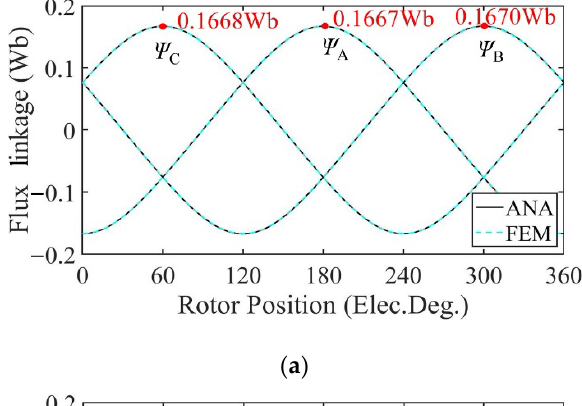
Figure 19. Harmonics in the flux-linkage relative to fundamental wave at fs = 166.67 Hz. ( a ) Analyt- ical model; ( b ) FE model. Figure 20 shows the no-load back-EMF of the motor calculated by the two models at a speed of 2000 rpm. Because the distribution of the magnetic field generated by the PMs changes after demagnetization, the no-load back-EMF induced by flux variation in the windings changes accordingly. In the case of uniform demagnetization, the magnetic field still maintains an even distribution. The amplitude of the no-load back-EMF under uni- form demagnetization decreases by about 5% compared with the healthy condition. Un- der the circumstance of partial demagnetization, the magnetic field generated by the PMs becomes uneven, introducing harmonics into the three-phase no-load back-EMF. The waveforms of the three-phase no-load back-EMF under partial demagnetization have ob- vious distortion.